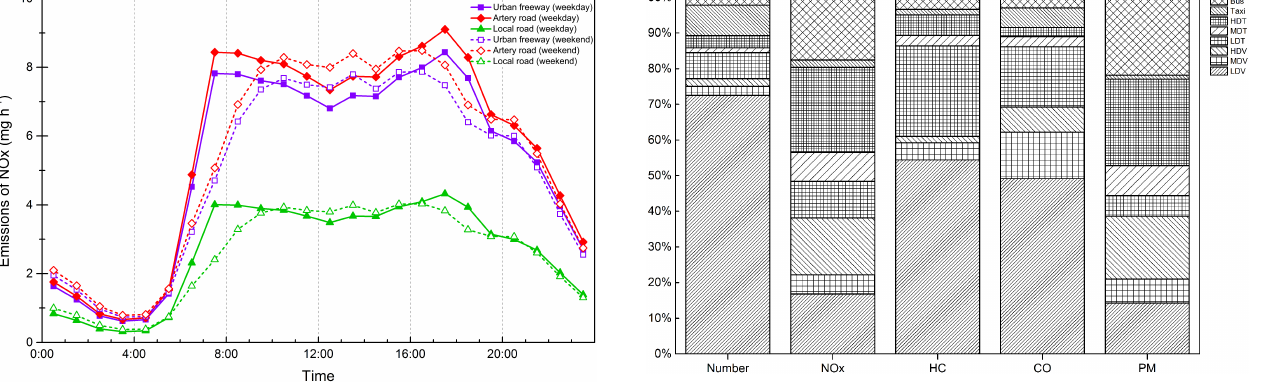
Figure 6. Hourly variation of vehicle emissions by road type on weekdays and weekends.